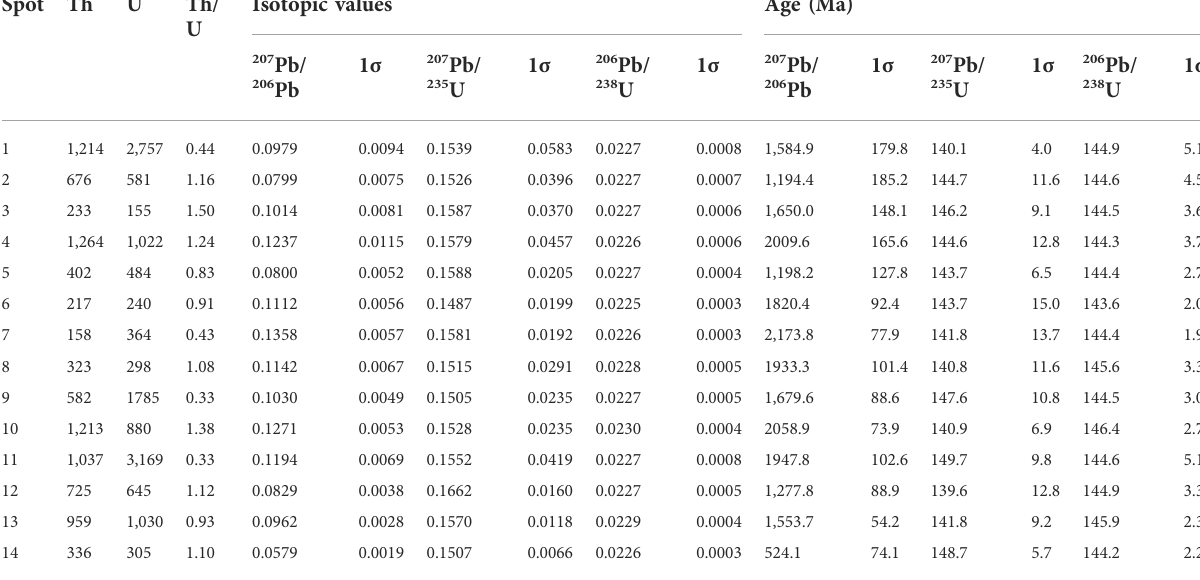
TABLE 1 Zircon LA-ICP-MS results of the alkali-feldspar granite from Shanagen hydrothermal vein-type Mo deposit. Spot